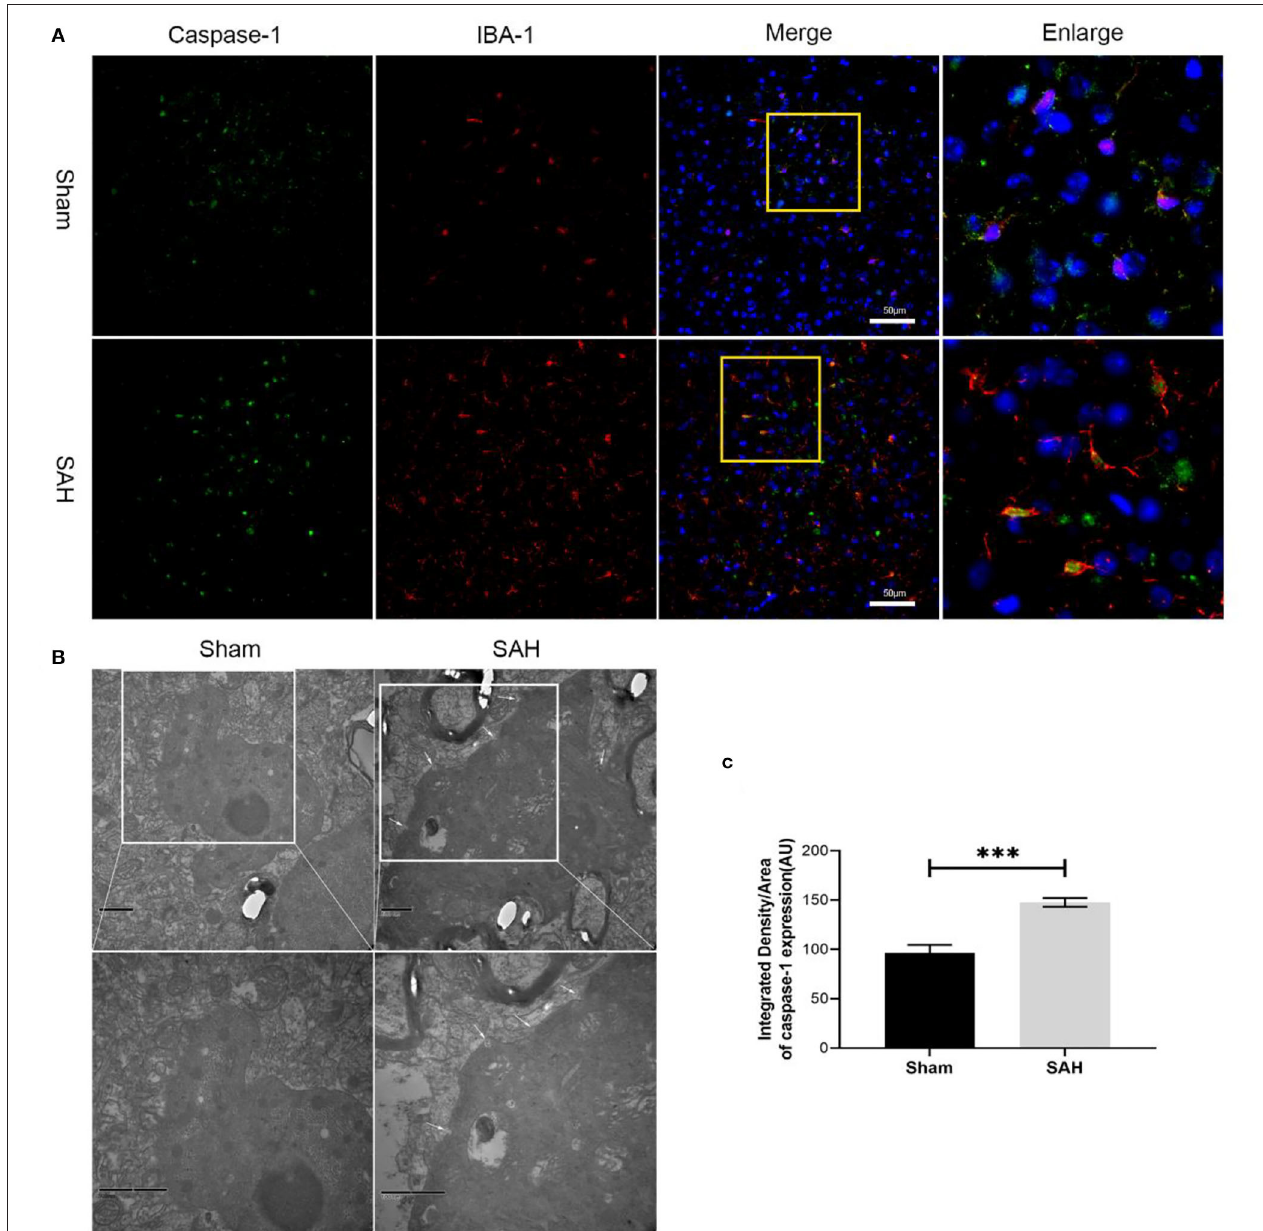
FIGURE 3 | Microglia expresses caspase-1 and representative transmission electron microscopy images. (A) Representative images of co-immunofluorescence staining of caspase-1 (green) and microglia (IBA1, red). Scale bars = 50 µ m. (B) Representative transmission electron microscopy images of microglia in ipsilateral cortex. Write arrow head: membrane pores. Scale bars = 500nm. (C) Quantitative analyses of caspase-1. Bars represent mean ± SD, n = 6 in each group. *** p <